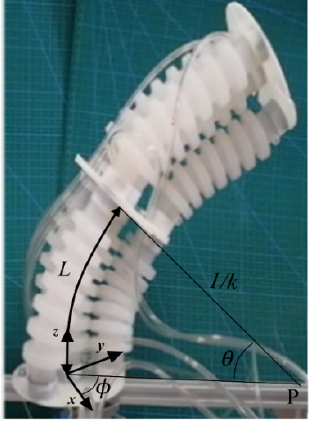
Figure 4. Main kinematic parameters of the soft manipulator.